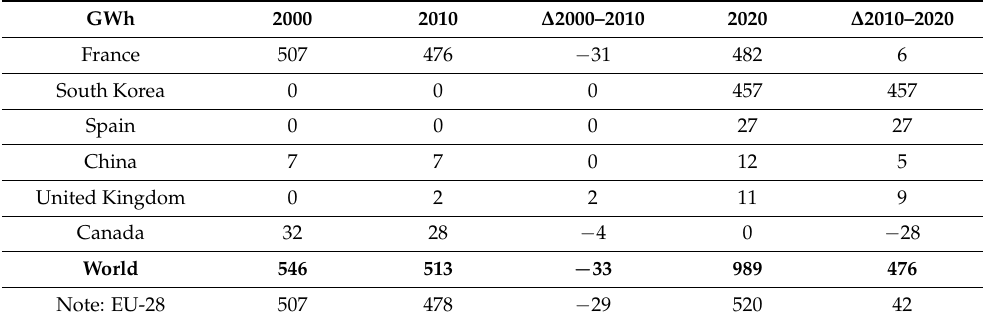
Table 4. Tidal, wave and ocean electricity generation (GWh) (based on